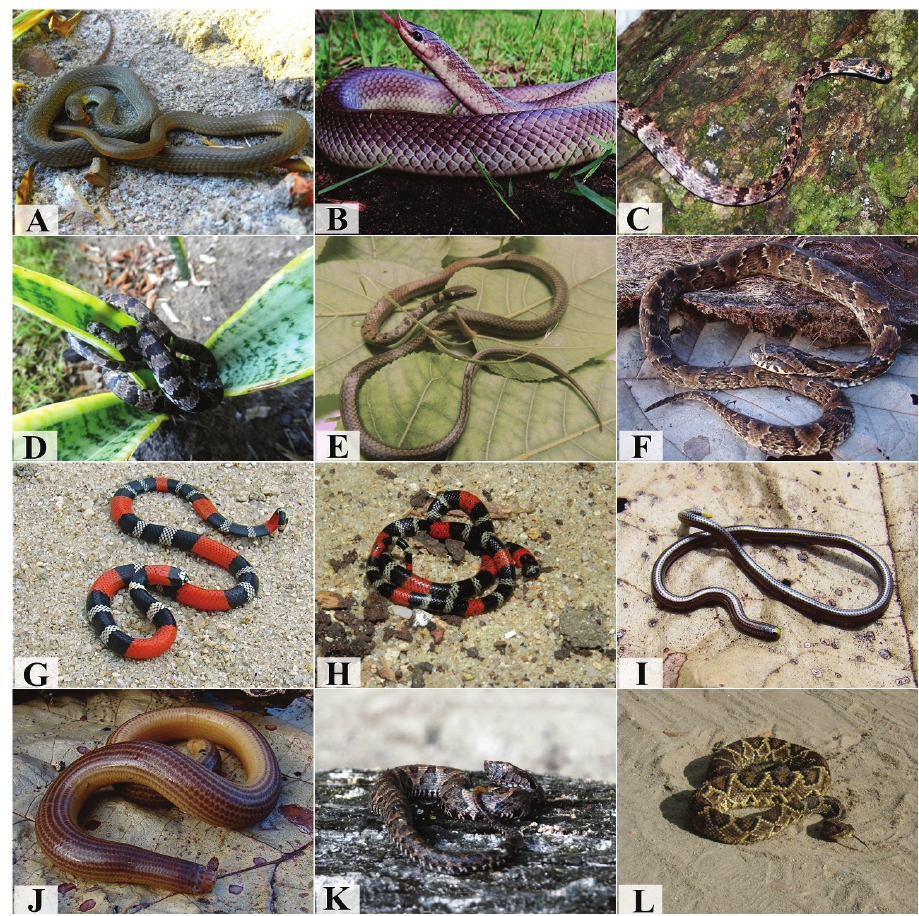
Figure 5. Species from the Atlantic Forest in south coast of Paraíba: A Philodryas patagoniensis B Phimo- phis guerini C Sibon nebulatus D Sibynomorphus mikanii E Taeniophallus occipitalis F Xenodon merremii G Micrurus ibiboboca H Micrurus potyguara I Epictia borapeliotes J Amerotyphlops brongersmianus K Bo- throps leucurus L Crotalus durissus . Photograph credits: Ivan L. Sampaio ( A, B, D, E, H, I ), Frederico G. França ( F, G, J, L ), Pedro T. S. Moura ( C ) Rafaela C. França ( K